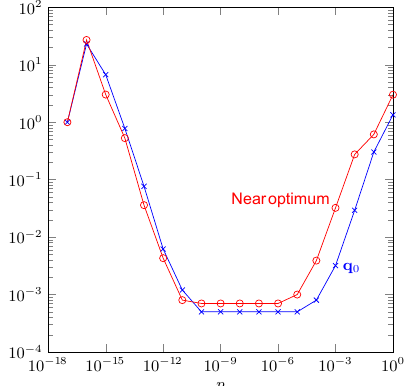
Figure 10. Error between finite-difference sensitivity and analyti- cal sensitivities according to Eq. (57) at an initial configuration q 0 and near one of the optimum configurations, plotted on a range of perturbation